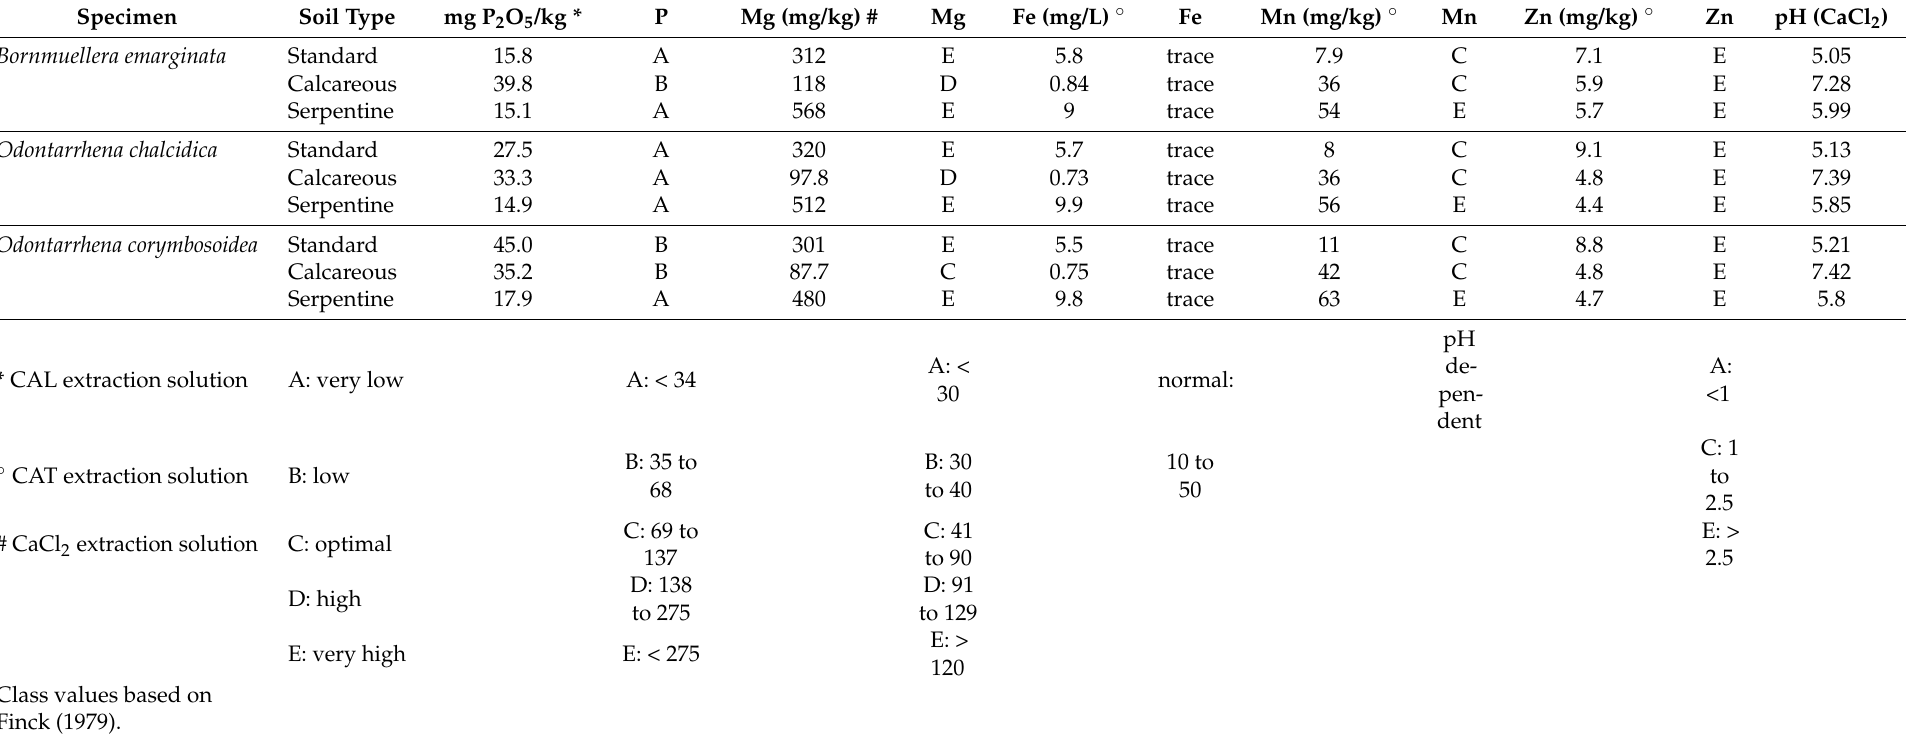
Table 2. Analyses of standard, calcareous, and serpentine soil chemistry for cultivated specimen of Brassicaceae.